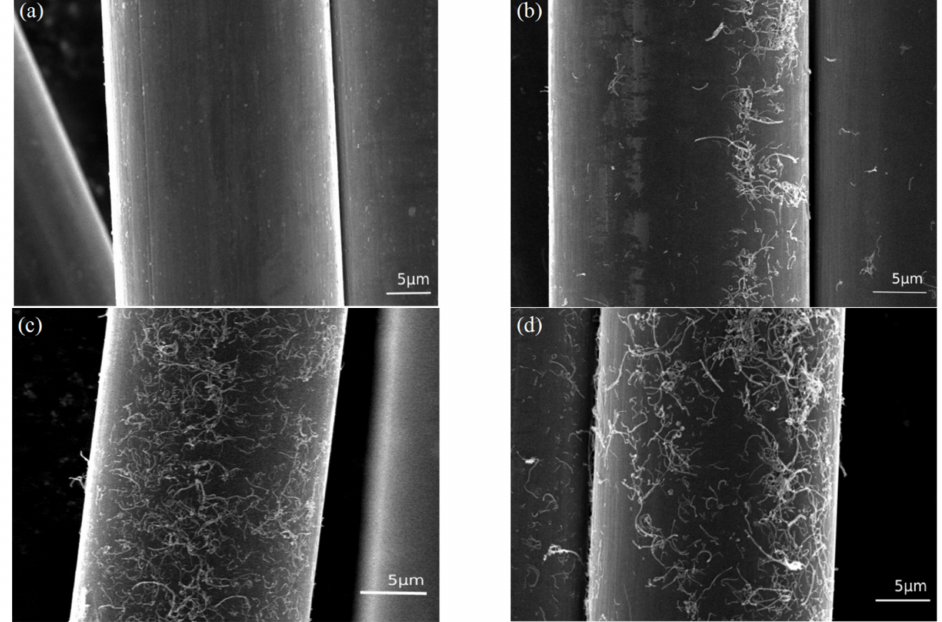
Figure 3. Scanning electron microscopy (SEM) images of the surface morphologies of carbon fiber: ( a ) Unsized carbon fiber, ( b ) CF-CNT 0.1 , ( c ) CF-CNT 0.2 , and ( d ) CF-CNT 0.3